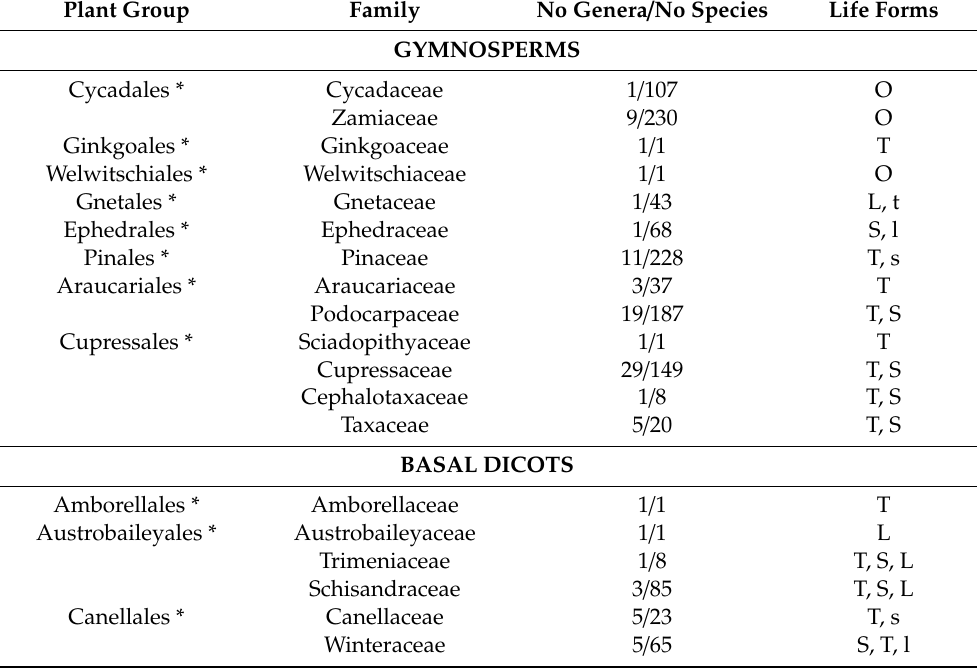
Table A1. List of vascular plant families composed entirely of woody species with an approximate number of genera and species [15,17–19,21,23,40]. Asterisks (*) indicate orders entirely composed of woody taxa (all species in all families are woody). The life forms are listed in order of importance. T: trees; S: shrubs; L: lianas; O: other woody forms—e.g., palm-like cycads. Capitals: the indicated life form is very common within the family. Lower case letters: the indicated life form is rarely found within the family. The order of plant groups and families follows Christenhusz and Byng